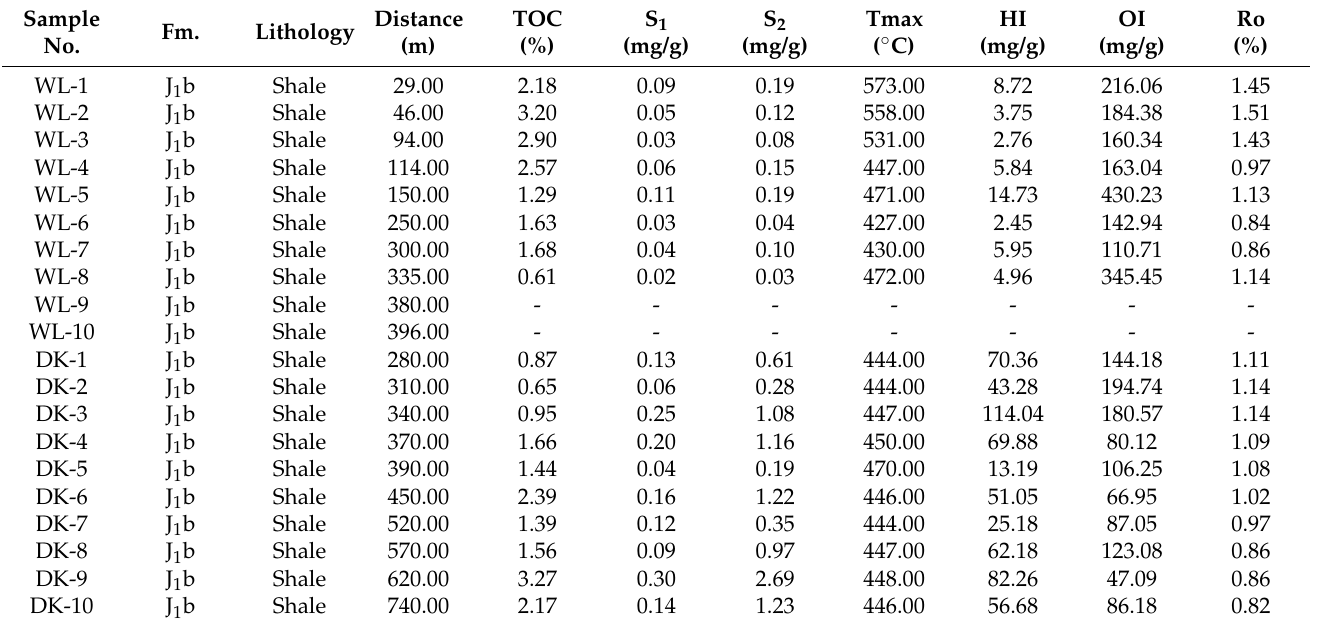
Table 1. Experimental results of Rock-Eval analysis and TOC measurement for source rocks.